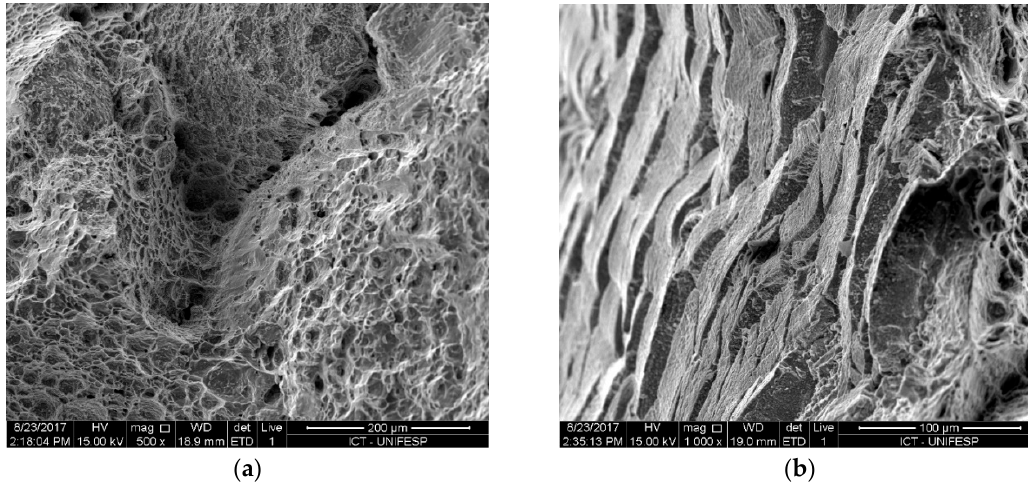
Figure 7. SEM micrographs showing surfaces after creep tests at 600 °C, 125 MPa and laser intensity of 2829 W/mm². ( a ) central region of creep test; ( b ) creep test border.